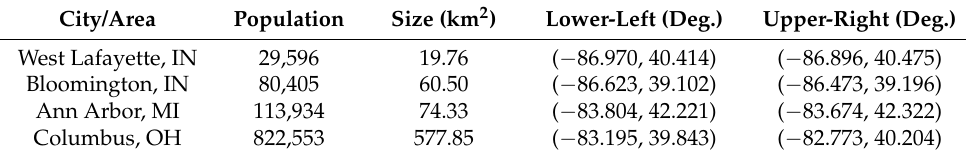
Table 1. Geo-demographic data of the four study